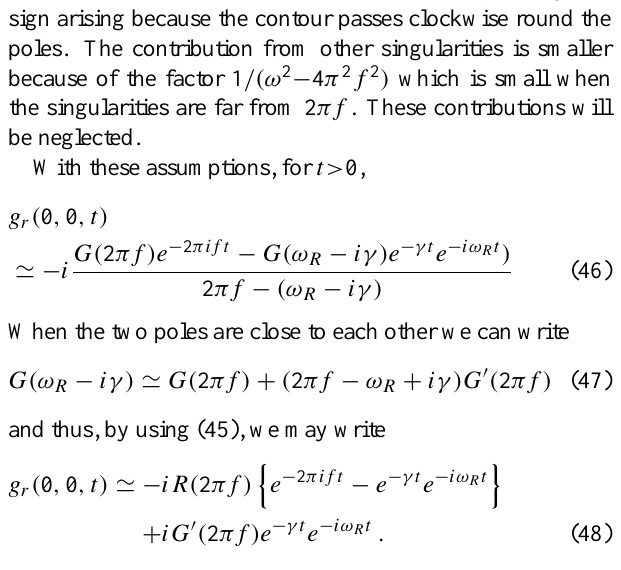
Fig. 11. Top panel: Directly driven re- flected signal when ω R = 2 πf . Middle panel: Contribution from excited leaky waveguide mode. Bottom panel: Super- position.